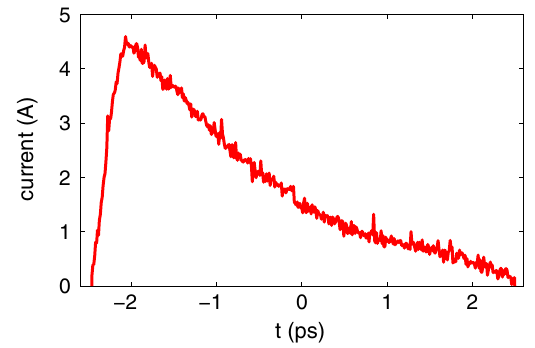
FIG. 5. Beam current distribution (head of the bunch to the left).